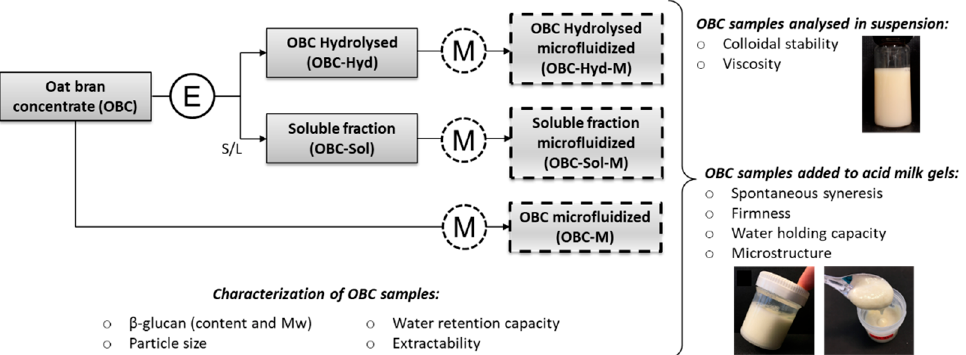
Figure 1. Setup of the experimental design. E = enzymatic treatment; M = Microfluidization; S/L = solid-liquid separation to recover the soluble fraction.